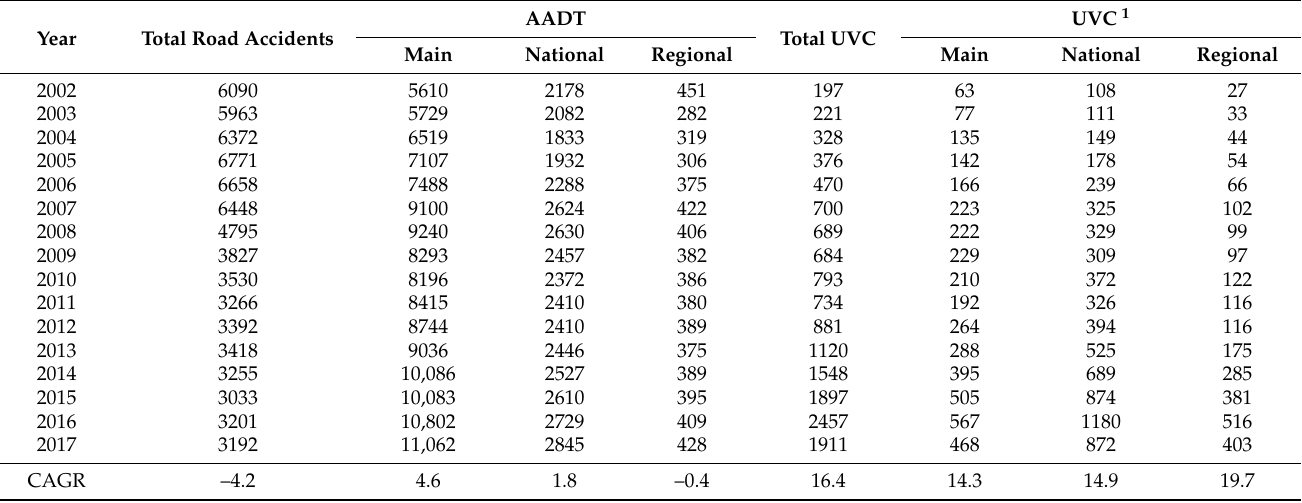
Table A1. The total number of road accidents, traffic intensity (AADT), and ungulate–vehicle collisions (UVCs) on different categories of roads.